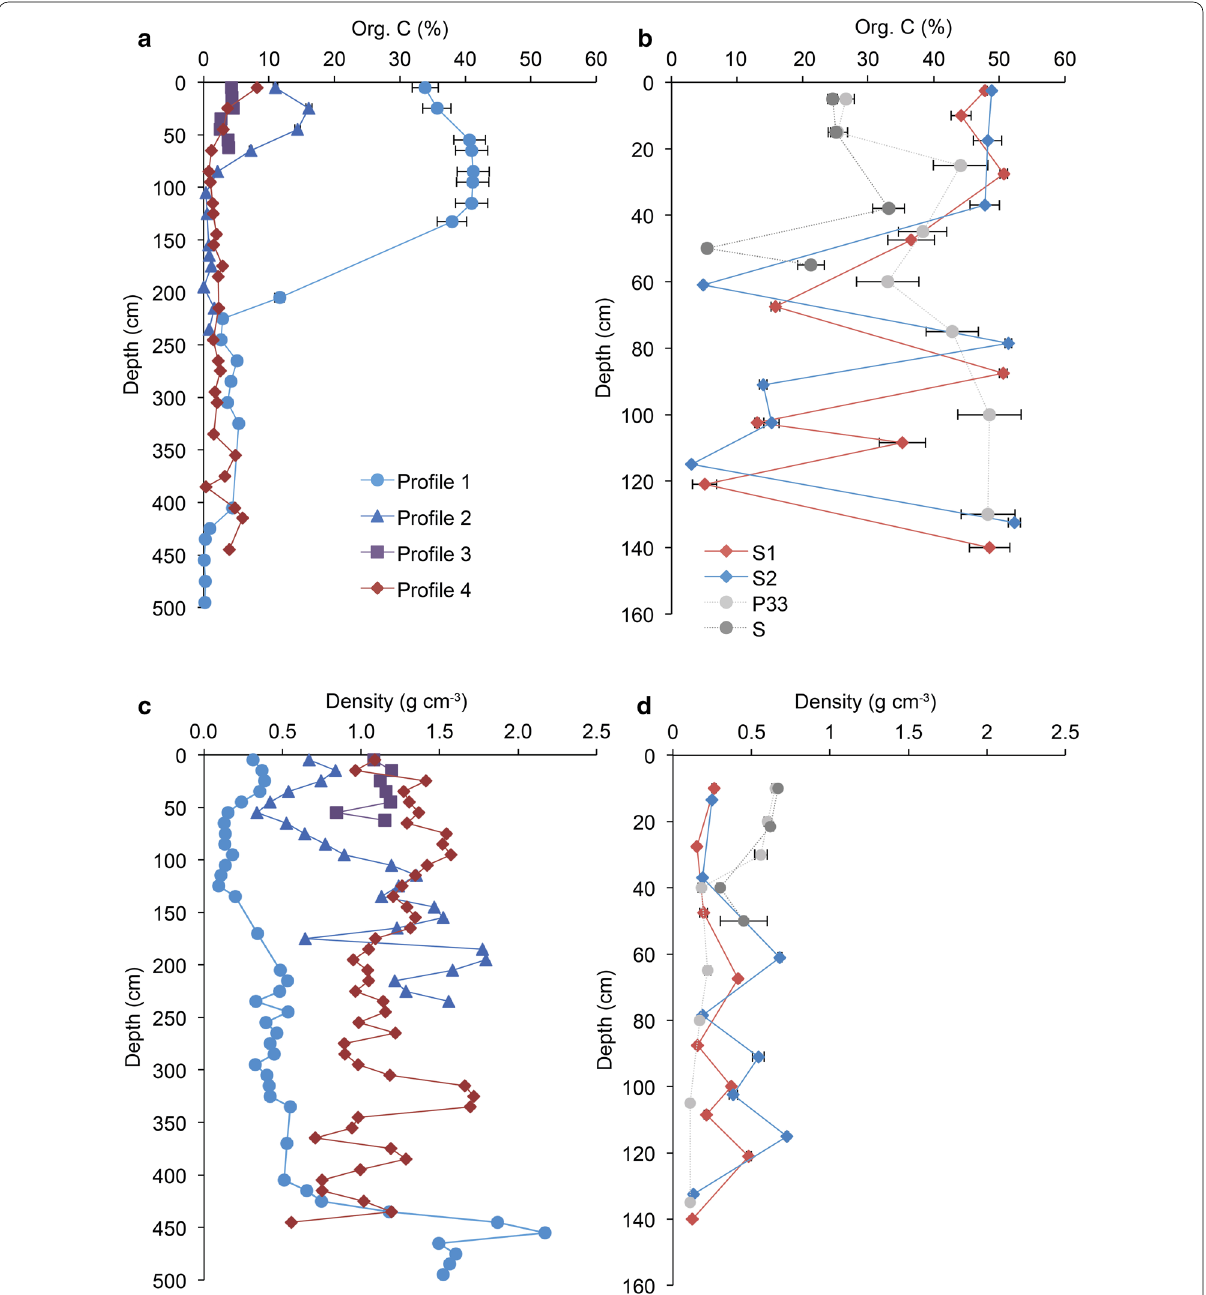
Fig. 5 Organic carbon content as a function of depth for a profiles 1–4, b S1, S2, P33, S and bulk density distribution at c profiles 1–4, d S1, S2, P33,